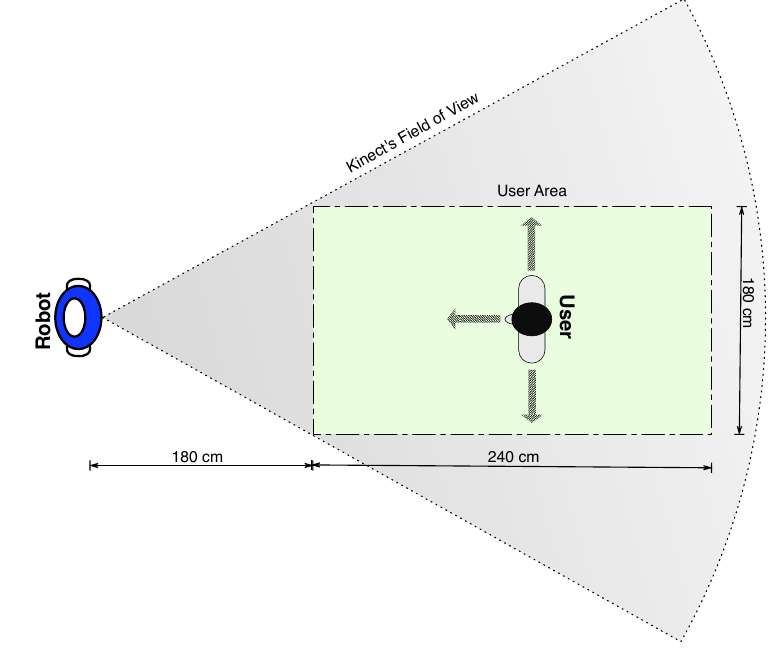
Figure 5. Scenario of the experiment —The cone represents the field of view of the Kinect sensor. The user was allowed to move inside the rectangle, as long as she always kept in the same pose while